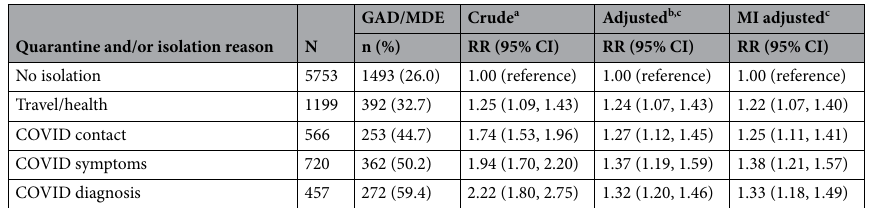
Table 3. Distribution of probable GAD and/or MDE indication by quarantine and/or isolation reason categories, together with relative risks (RRs) and associated 95% confidence intervals (CIs) estimates from crude and adjusted complete case multilevel logistic models, and the multiple imputed (MI) adjusted multilevel logistic model. a 332 (3.7%) respondents missing; b 1097 (12.2%) respondents missing; c adjusted for sex, age, essential worker, household composition, financial losses, threat perceived to oneself and/or family, threat perceived for country and/or world, being a victim of stigma, level of information about COVID-19, trust in authorities score, social networks used as a regular source of information, friend/family/co-workers as a regular source of information, sense of coherence.